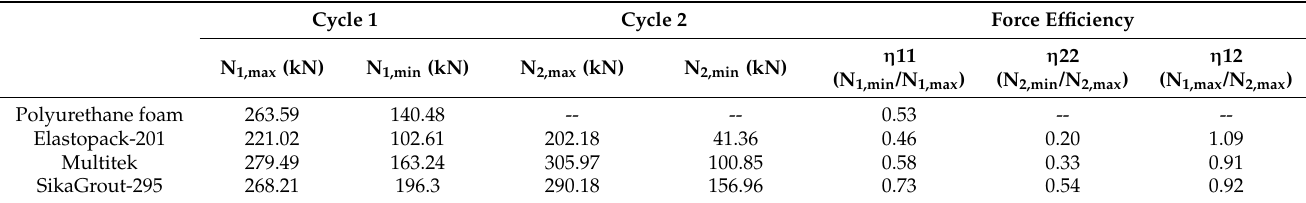
Table 3. Results obtained during the tests in each of the cycles (maximum and minimum) and the load efficiency coefficients η 11, η 22 and η 12. Cycle 1 Cycle 2 Force